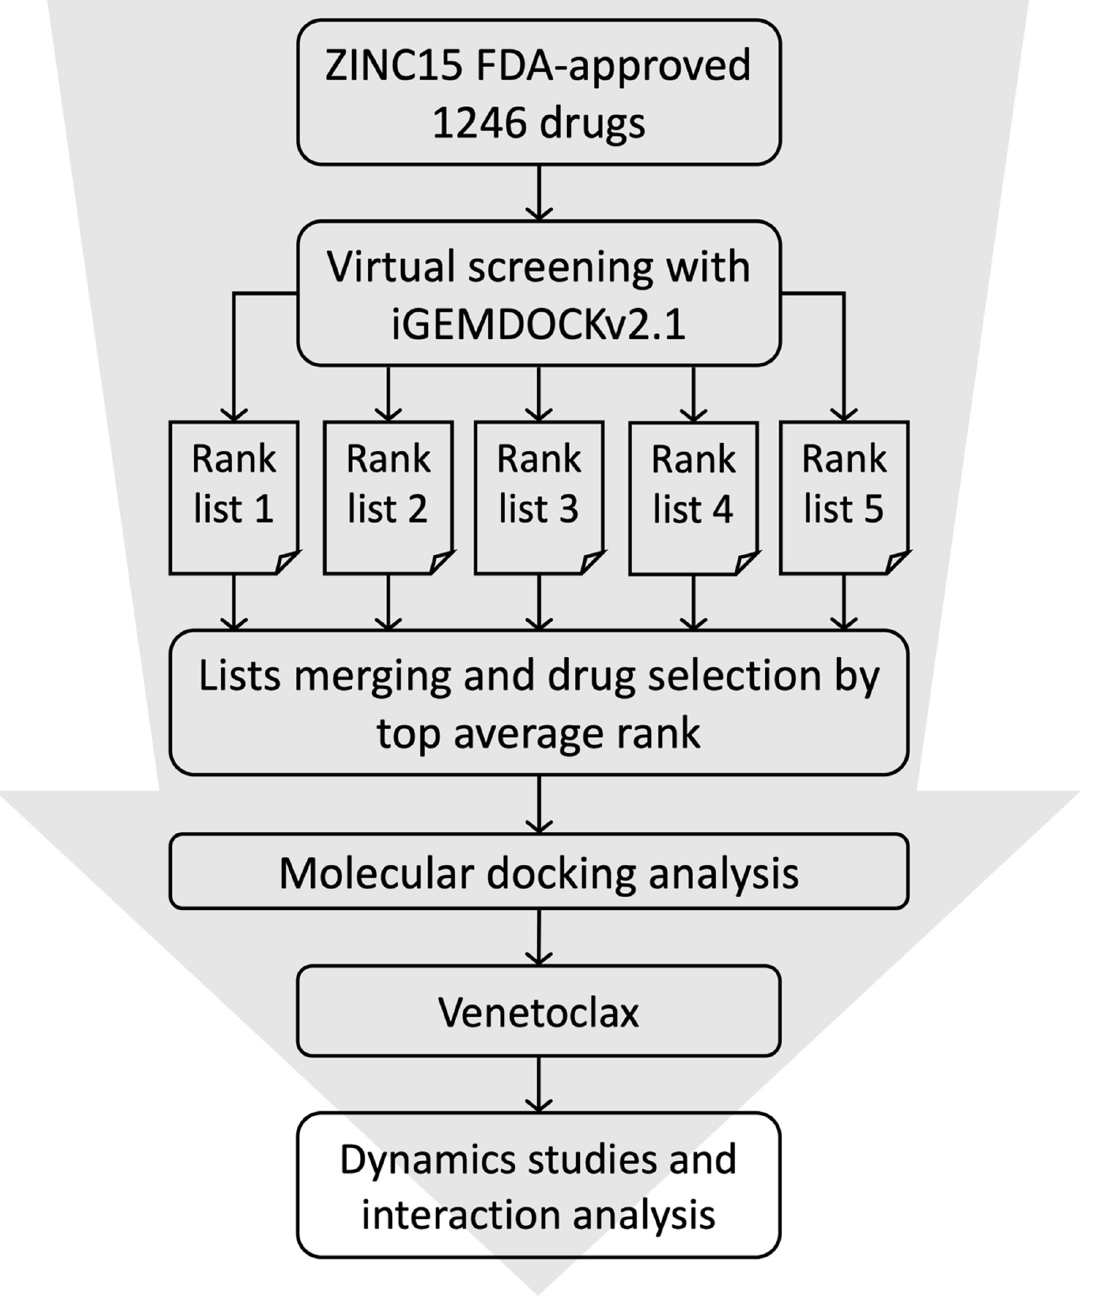
Figure 1. Virtual screening workflow for the identification of the potential S1-RBD binding drugs.